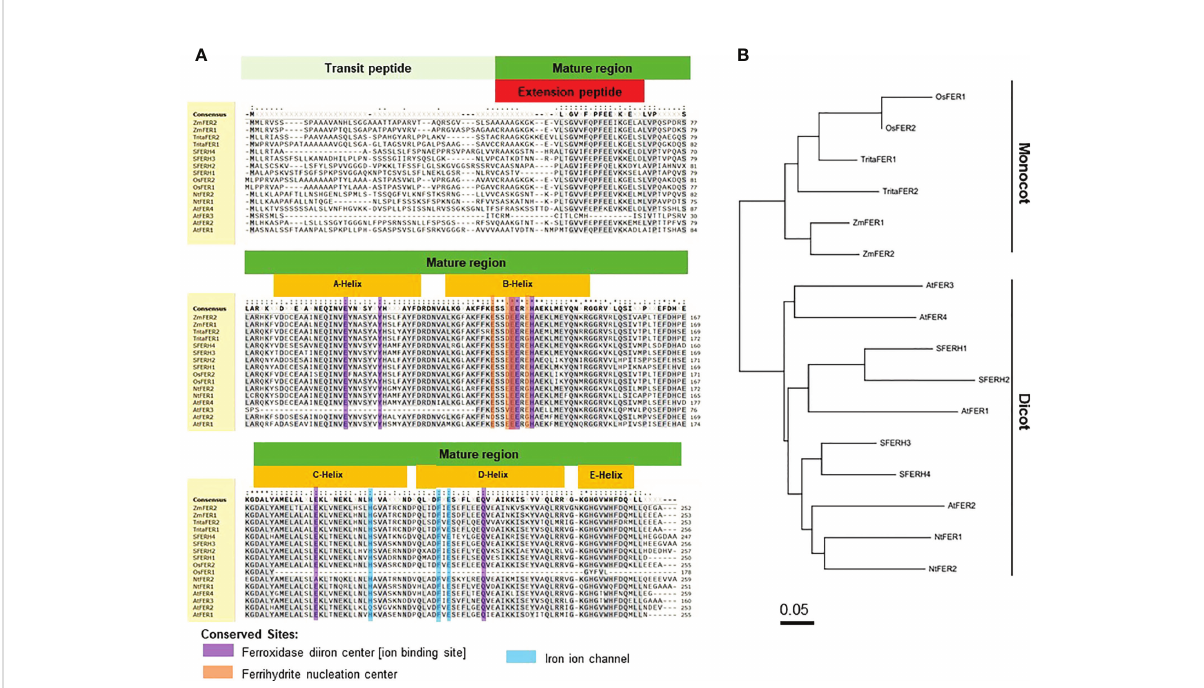
FIGURE 1 Amino acid sequence alignment and phylogenetic tree of rice ( Oryza sativa) ferritins with other plant ferritins. (A) Amino acid sequence alignment and (B) phylogenetic tree of ferritins in Oryza sativa , Triticum aestivum , Zea mays , Glycine max , Arabidopsis thaliana , and Nicotiana benthaminana. The phylogenetic tree of ferritins was constructed using MEGA X: Molecular Evolutionary Genetics Analysis across computing platforms (Kumar et al., 2018). Amino acid sequence alignment is presented by SnapGene Viewer version 5.2.4. Residues that are conserved across at least 70% sequences were highlighted in grey. Different symbols indicate identical amino acid residues: conserved sequence (*), conservative mutations (:), semi-conservative mutations (.), and non-conservative mutations ( ). The global consensus sequence is shown on top of the alignment; gaps are represented by ( - ) and ambiguous symbols are represented by (X). Accession numbers: OsFER1 (Os11g01530), OsFER2 (Os12g01530), TritaFER1 (AY864925), TritaFER2 (EU143671), ZmFER1 (X61391), ZmFER2 (X61392), SFERH1 (M64337), SFERH2 (AB062754), SFERH3 (AB062755), SFERH4 (AB062755), AtFER1 (AT5G01600), AtFER2 (AT3G11050), AtFER3 (AT3G56090), AtFER4 (AT2G40300), NtFER1 (AY083924), and NtFER2